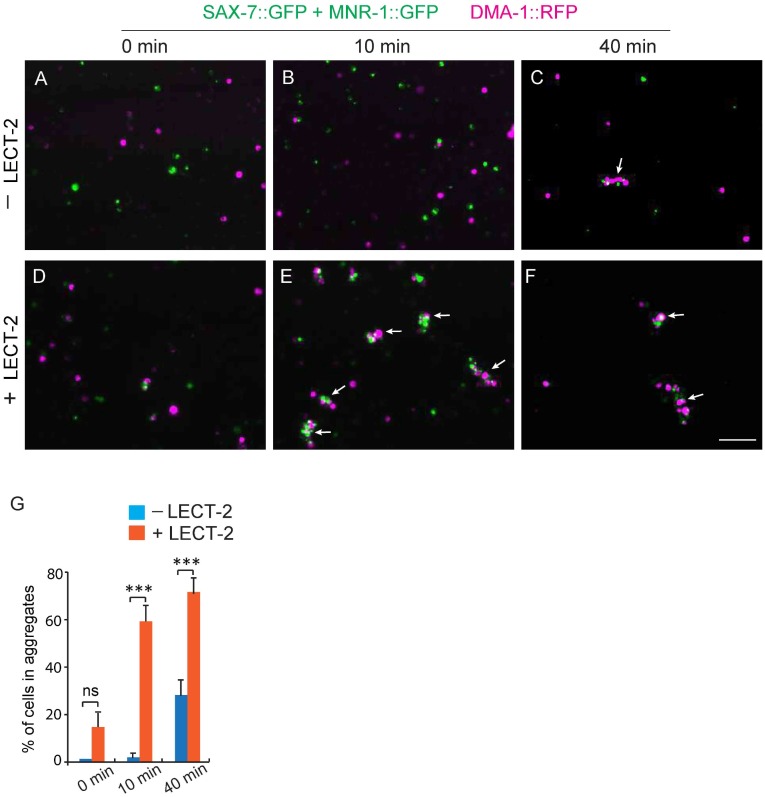
Adding LECT-2::FLAG increases the aggregation formation between DMA-1::RFP and SAX-7::GFP-MNR-1::GFP -expressing S2 cells.(A–F) Fluorescent images showing the results of S2 cell aggregation assays at specific time points. Magenta cells: expressing DMA-1::RFP; Green cells: expressing SAX-7::GFP and MNR-1::GFP. –LECT-2: medium collected from non-transfected S2 cells was used; +LECT-2: medium collected from Pactin>lect-2::flag cells was used. Arrows: S2 cell aggregates. (G) Quantification of percentage of cells in aggregates. %=total number of cells in aggregates (green cells+ red cells)/ total number of cells (green cells+ red cells). Student’s t-test was used for statistical analysis. ***p<0.0001. n﻿s: not significant. Data are represented as mean ± SEM. Scale bar: 100 μm.